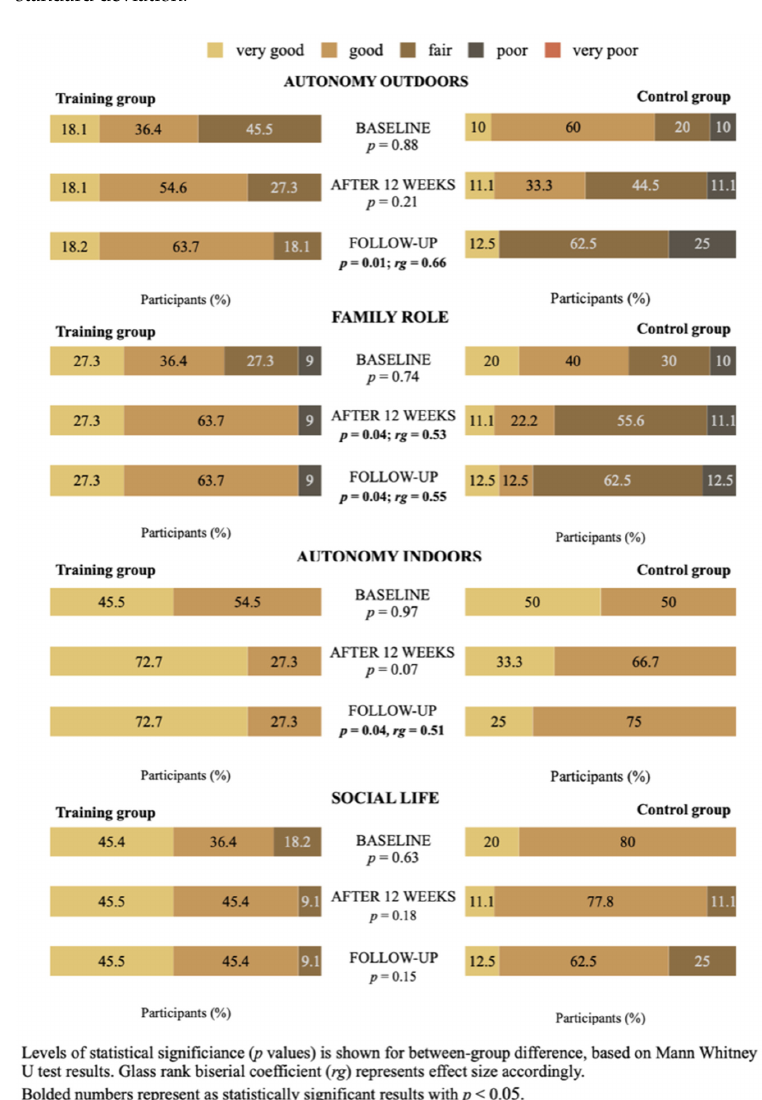
Figure 3. Comparison of IPA sub-scales median score at baseline, after 12 weeks and follow-up assessments in training and control groups.